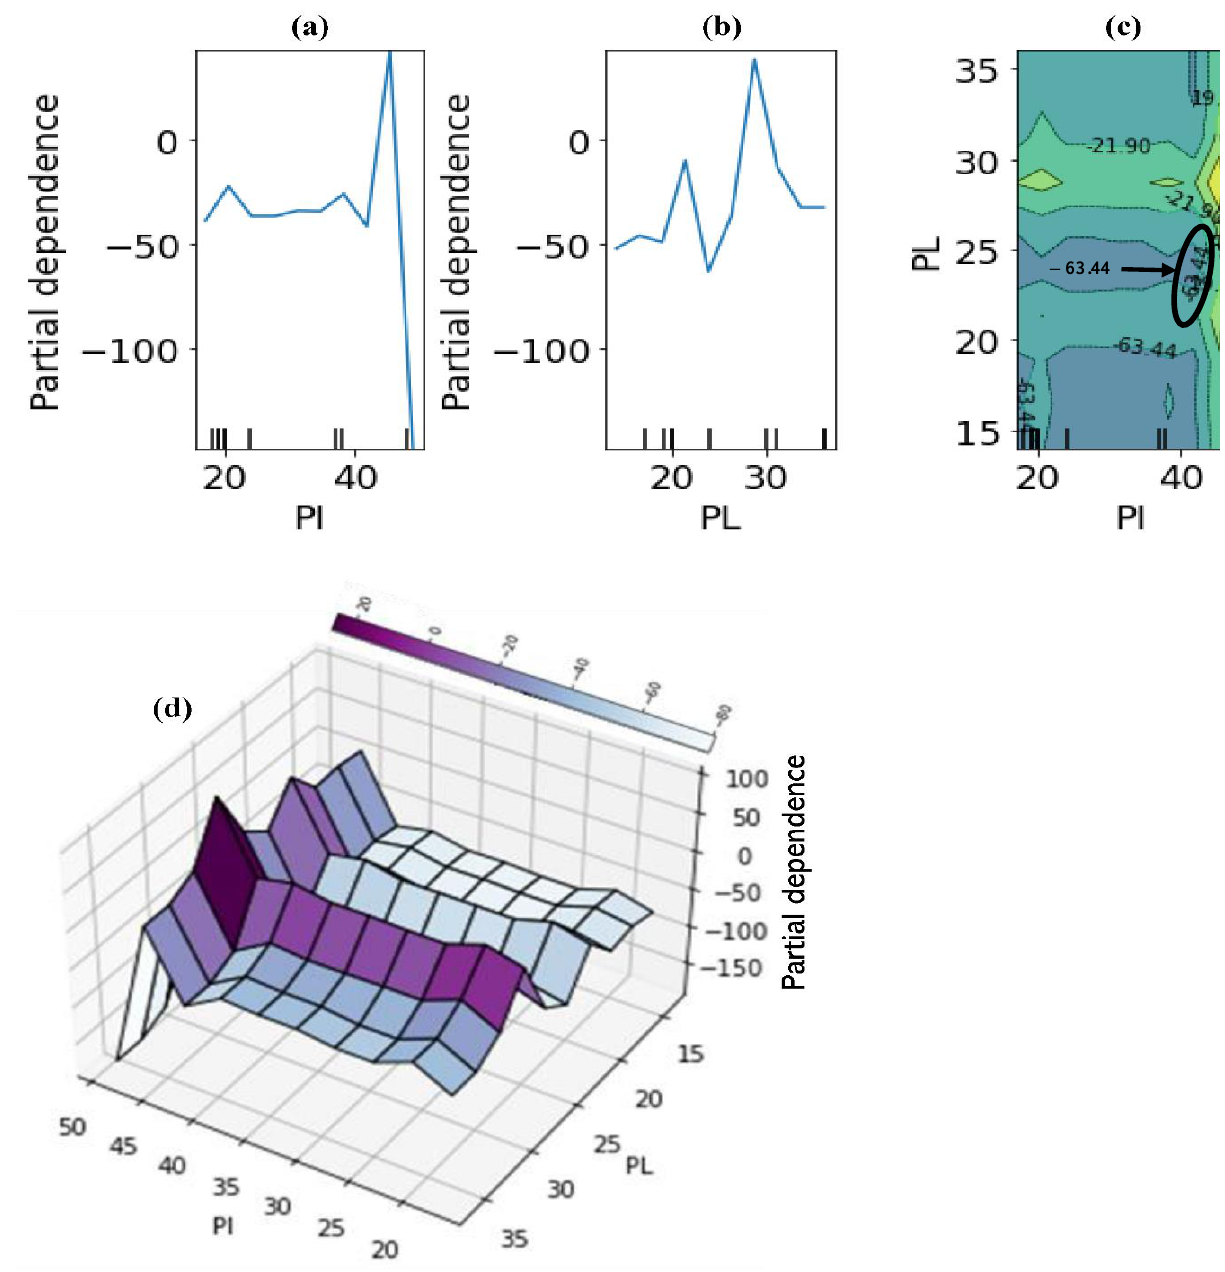
Figure 14. Partial dependence plots: ( a ) one-way dependence for PI, ( b ) one-way dependence for LL, ( c ) two-way dependence for soil plasticity features, ( d ) 3-dimensional two-way dependence for soil plasticity features (Python, version 3.8).